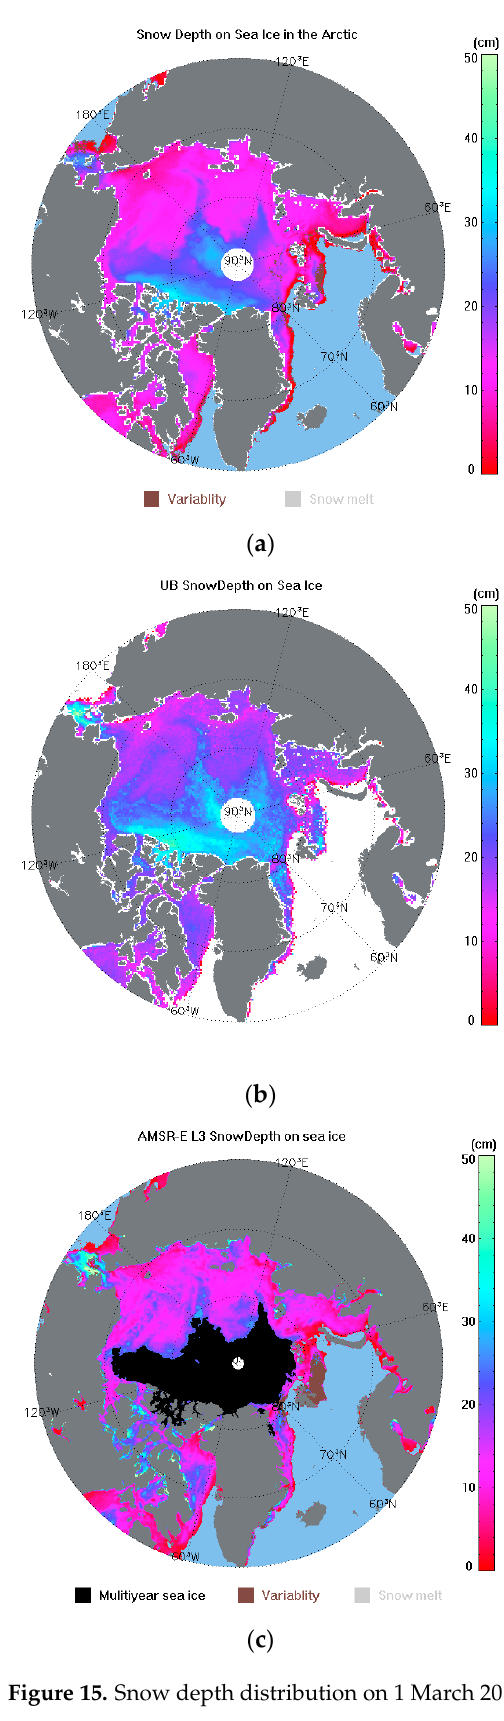
Figure 15. Snow depth distribution on 1 March 2011, from ( a ) RSD, ( b ) SD_UB, and ( c ) AMSR-E.